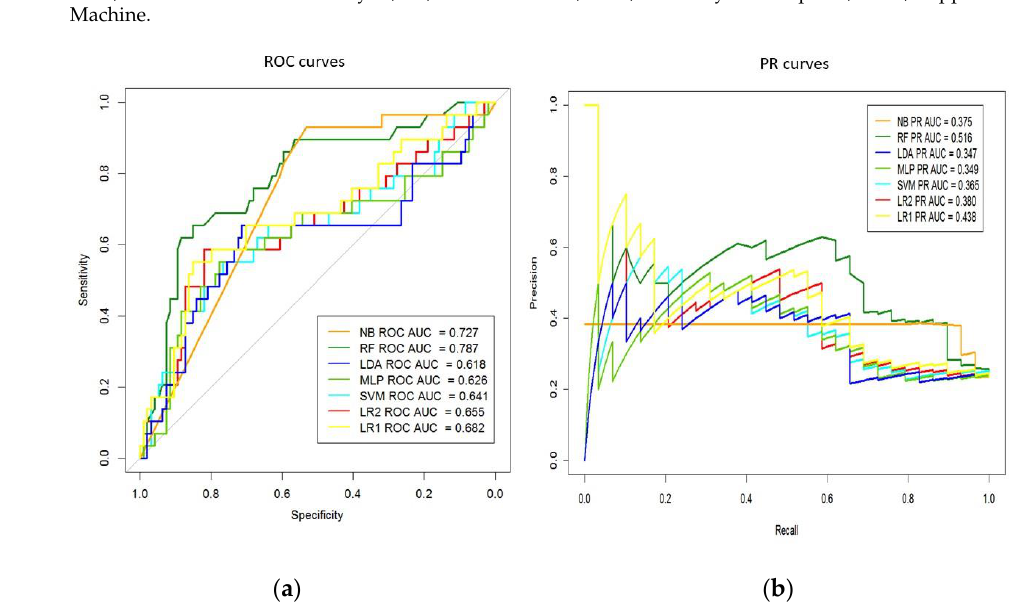
Figure 2. ( a ) Areas under the receiver operating characteristic (ROC) and ( b ) precision/recall (PR) curves for machine-learning models. AUC, Area Under the Curve; LDA, Linear Discriminant Analysis; MLP, Multi-layer Perceptron; NB, Naive Bayes; RF, Random Forest; LR, Logistic Regression; SVM, Support Vector Machine . Table 2. Prediction Ability of the Reference Model (LR2, Linear Regression2) and five Machine Learning Models, measured in terms of AUC-ROC, Sensitivity, Specificity, Accuracy, and Precision values to predict MACE, using 8-fold cross-validation of 123 patients from the testing dataset.